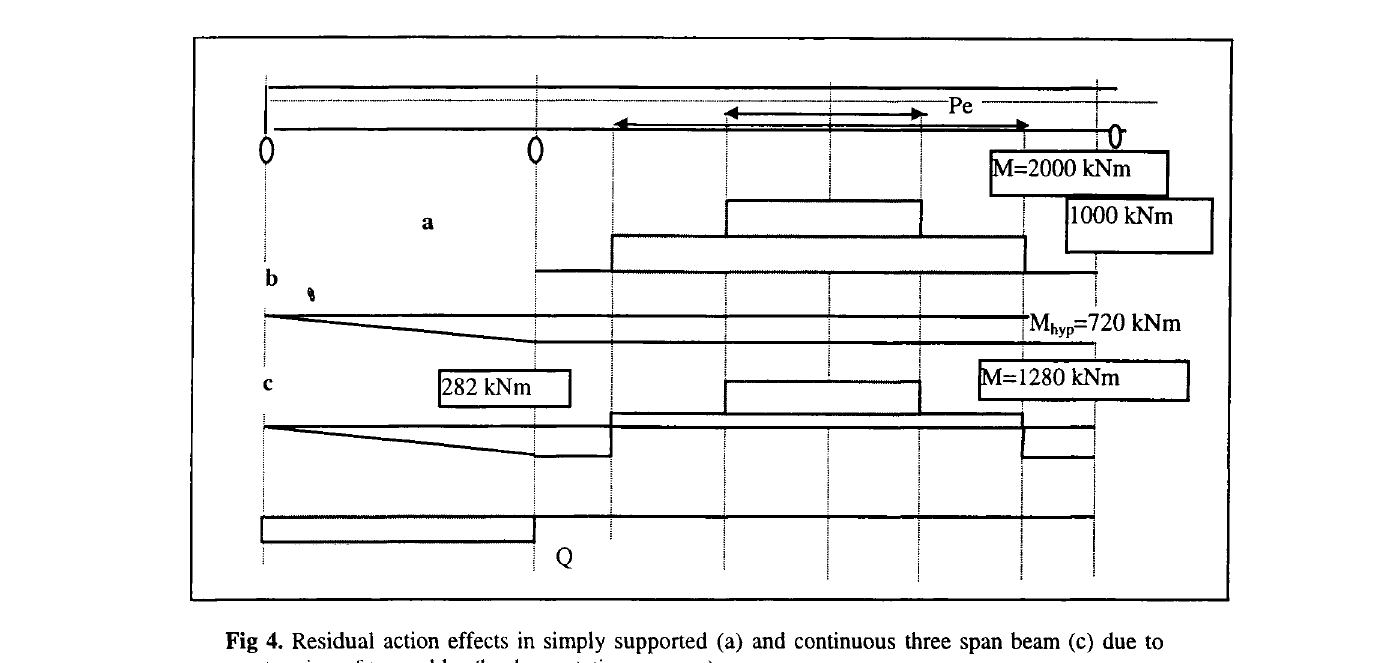
Fig 4. Residual action effects in simply supported (a) and continuous three span beam (c) due to prestressing of two cables (b- hyperstatic moments)